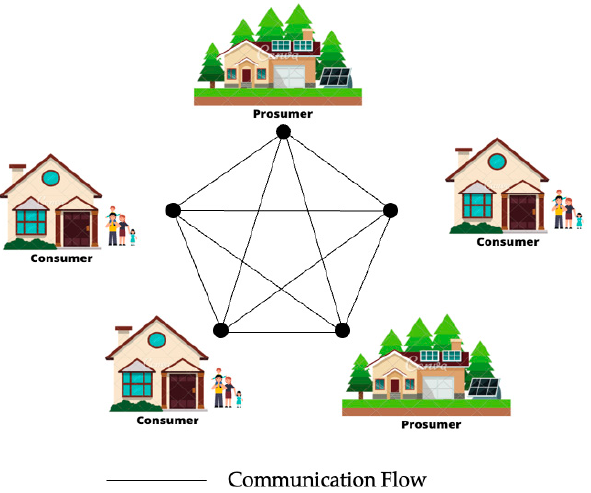
Figure 13. Blockchain flow of information between the blockchain nodes.